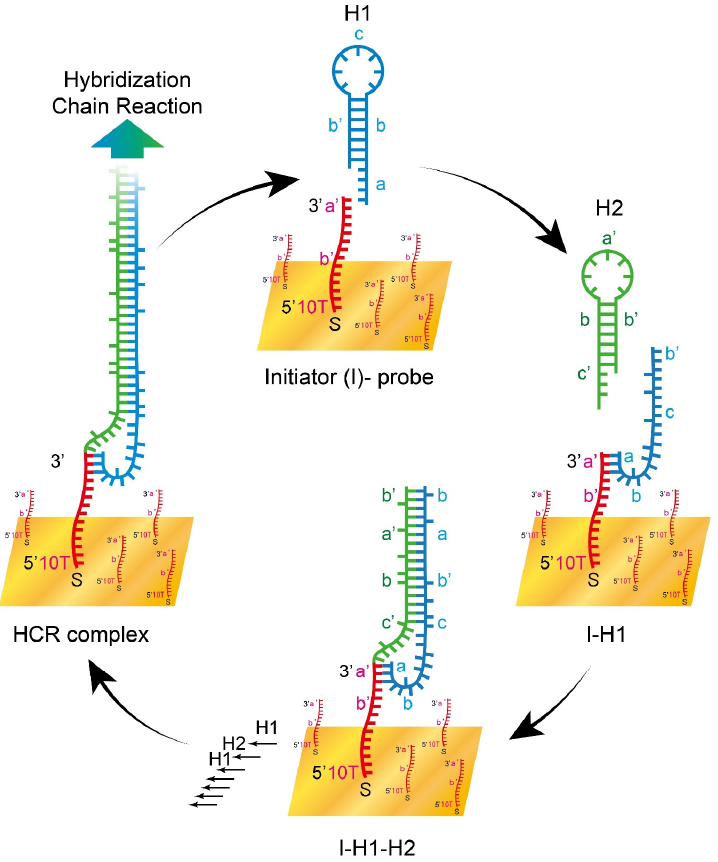
Figure 3. Schematic illustration of the HCR-pSPR self-assembly on gold surface detection plat- form.